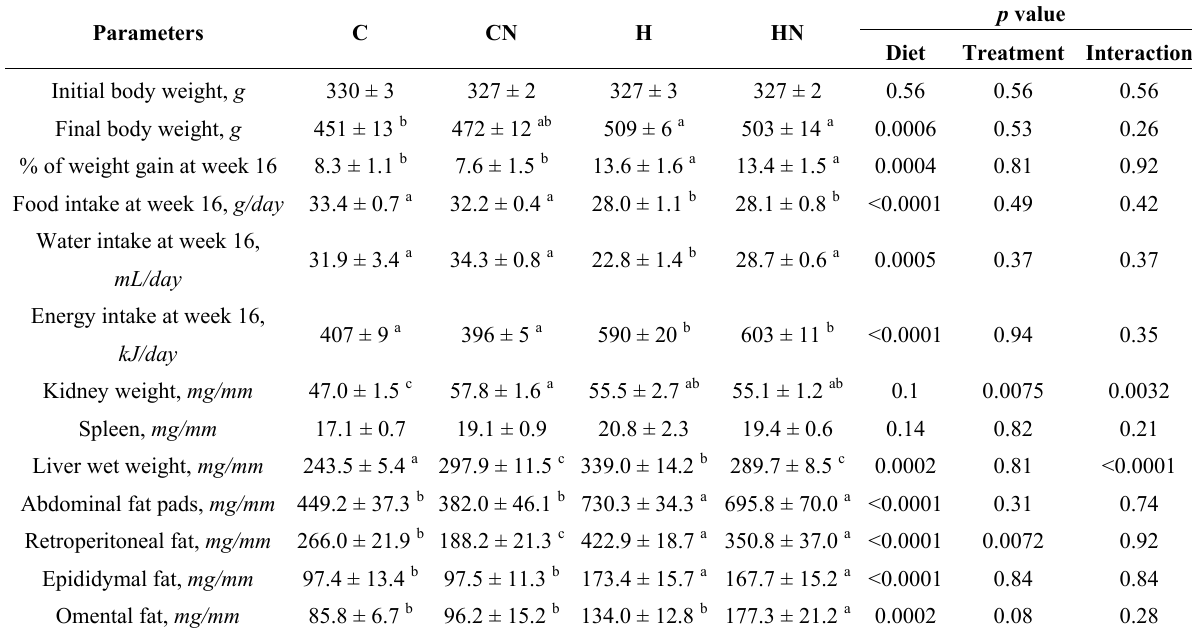
Table 1. Naringin on body weights, food and water intakes and organ wet